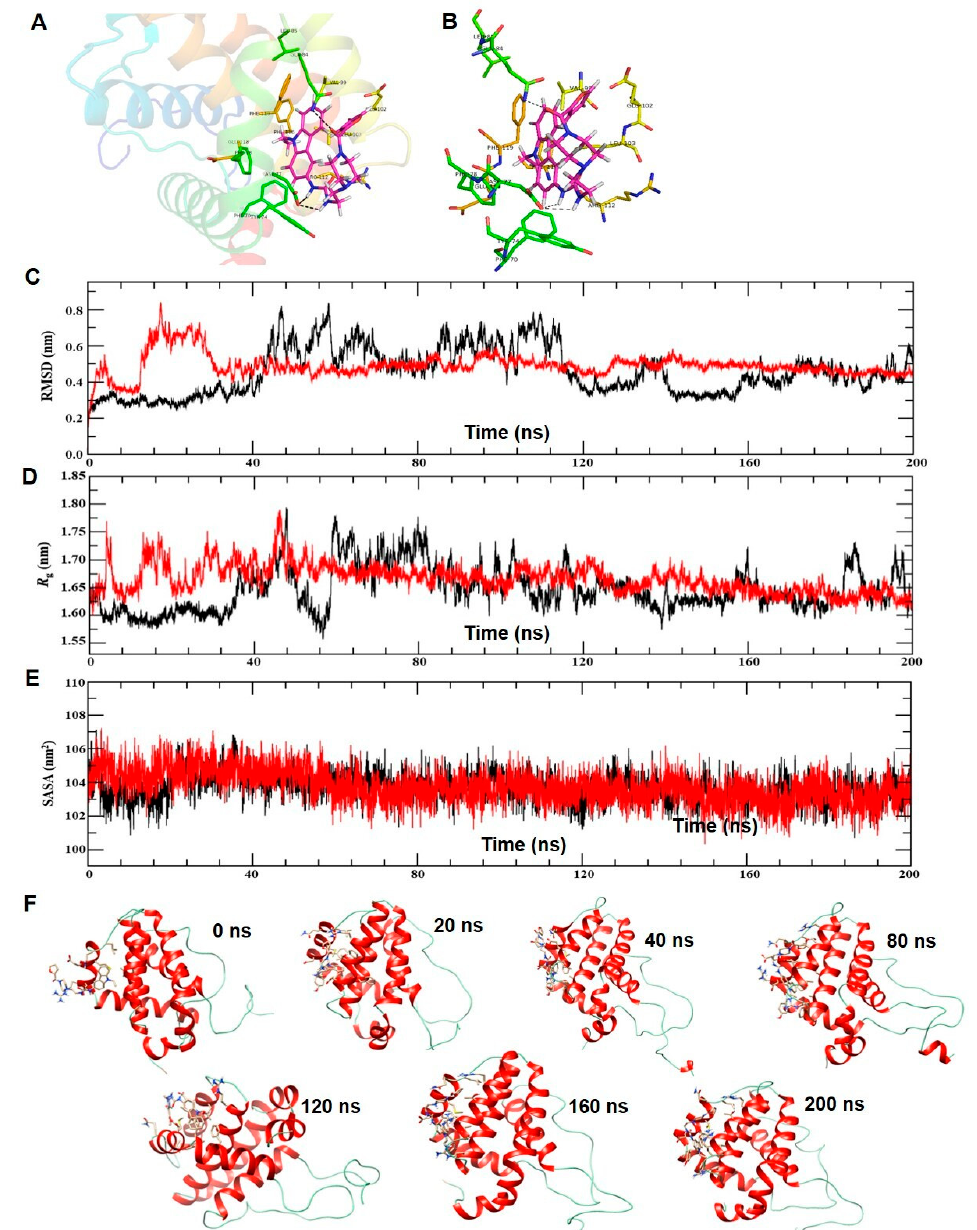
Figure 2. BCL-2-ECPU-0001 interaction by molecular docking and molecular dynamics (MD) simulations. ( A ) Stereo view of BCL-2-ligand complex at PyMol. The cartoon view of BCL-2 docked with ligand. The active site residues and ligand are represented with stick. ( B ) Detail view of interatomic interactions of active site residues and ligand. The active sites residues are shown with stick and the ligand is represented with ball and stick model. ( C ) Time evolution plot of root mean square deviation (RMSD) plot of BCL-2 (black) and BCL-2-ligand complex (Red) in water at 300 K during the MD simulation of 0–200 ns. ( D ) Time evolution plot of radius of gyration (R g ) plot of BCL-2 (black) and BCL-2-ligand complex (Red). ( E ) Time evolution plot of SASA. Protein BCL-2 shown with color black and BCL-2-ligand complex is represented with color red. ( F ) Structural snap of BCL-2-ligand at the different time interval of MD simulation in water at 300 K. The ligand and active site residues involve in interactions are shown with stick. The cartoon view of BCL-2-ligand at molecular visualizer tool Chimera 1.13.